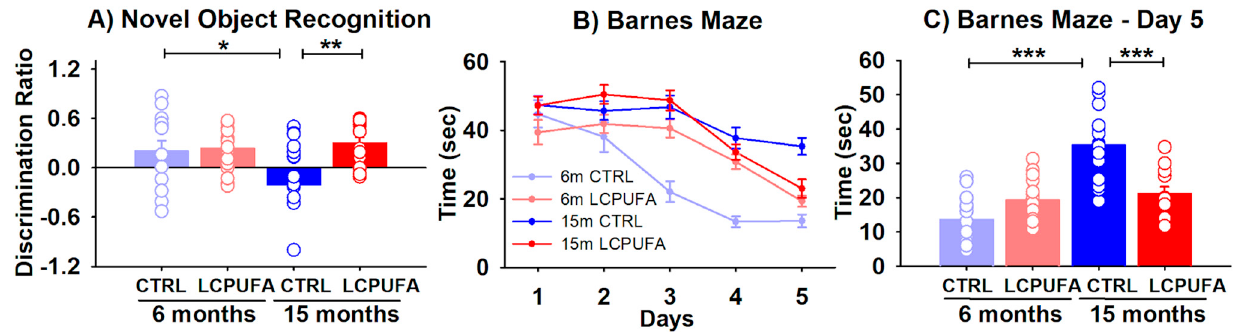
Figure 1. Behavioral tests for the four experimental groups. A n-3 LCPUFA-enriched diet improves spatial and recognition memory in aged female mice. ( A ) Recognition memory was assessed by a novel object recognition task, in which the discrimination ratio was calculated as the difference in exploration time for the novel object minus that for the familiar object divided by the total exploration time. Bars represent the mean ratio ± SEM of 13–18 animals per group. Circles represent each individual measurement. Results were analyzed by a 2-way ANOVA (diet, age) followed by a Tukey’s multiple comparisons test (* p < 0.05; ** p < 0.01). ( B ) Spatial learning was measured by quantifying the escape time during the 5 days-training. Data were analyzed by a 3-way ANOVA (diet, age, day of training) and individual points in each curve represent the mean ± SEM of 13–16 animals per group. ( C ) Spatial memory achieved in the 5th training day was analyzed separately by representing the mean escape time ± SEM of the four experimental groups, 12–16 animals per group. Results were analyzed by a 2-way ANOVA (diet, age) followed by a Tukey’s multiple comparisons test (*** p < 0.001).